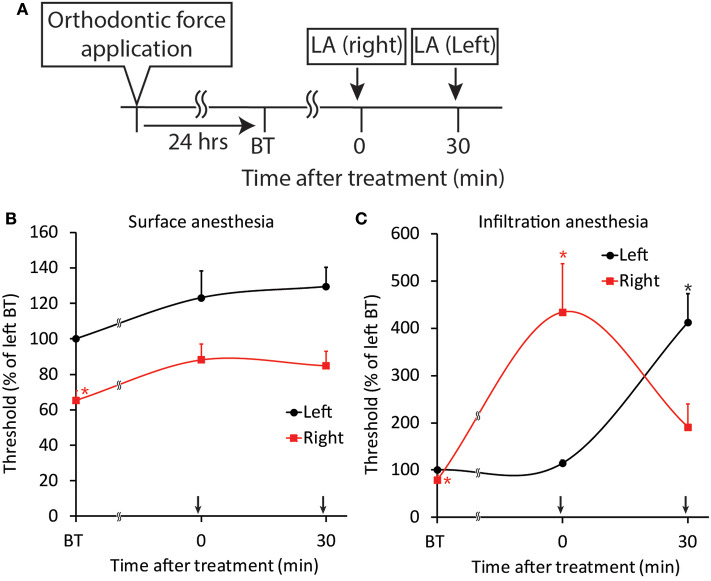
Effect of local anesthesia on orthodontic treatment-induced excitation of the jaw-opening reflex. (A) Experimental procedure for the application of orthodontic force, local anesthesia, and the evaluation of jaw-opening reflex excitability. (B) Surface anesthesia applied to the right maxillary first molar region significantly increased the right-side threshold for inducing the jaw-opening reflex. (C) Infiltration anesthesia applied to the right maxillary first molar region increased the right-side threshold for inducing the jaw-opening reflex. LA, local anesthesia; BT, before treatment (local anesthesia). Arrow: local anesthesia. Two-way ANOVA, side: p < 0.05, time: p < 0.05, side × time: p < 0.05; Dunnett's post hoc test, *p < 0.05: vs. “BT of left”.